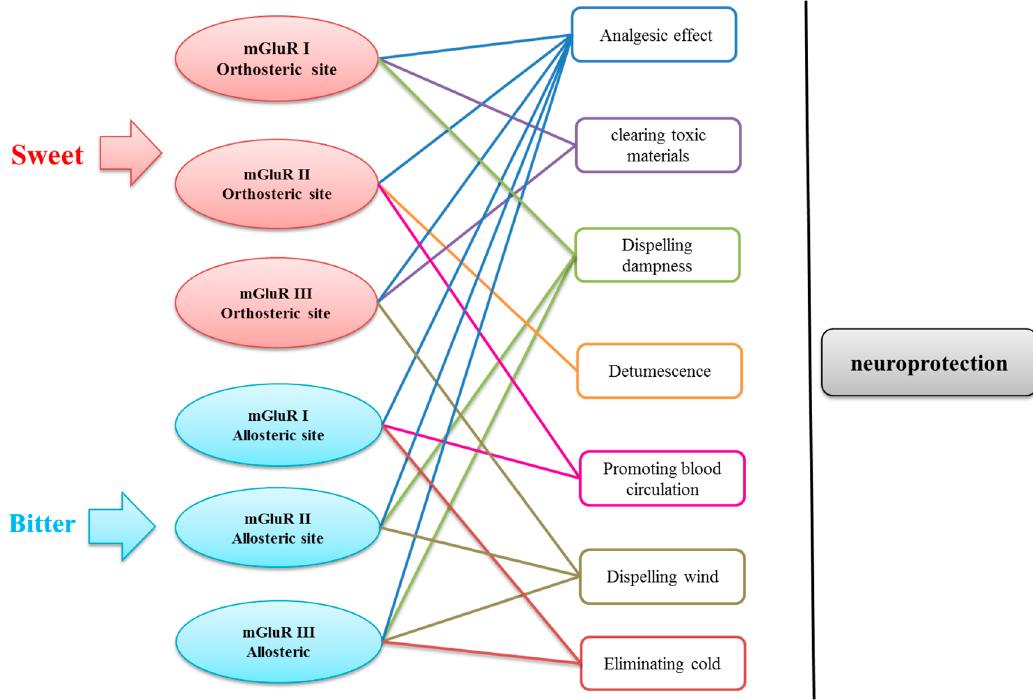
Figure 8. The sketch map of flavors, targets, and efficiencies.